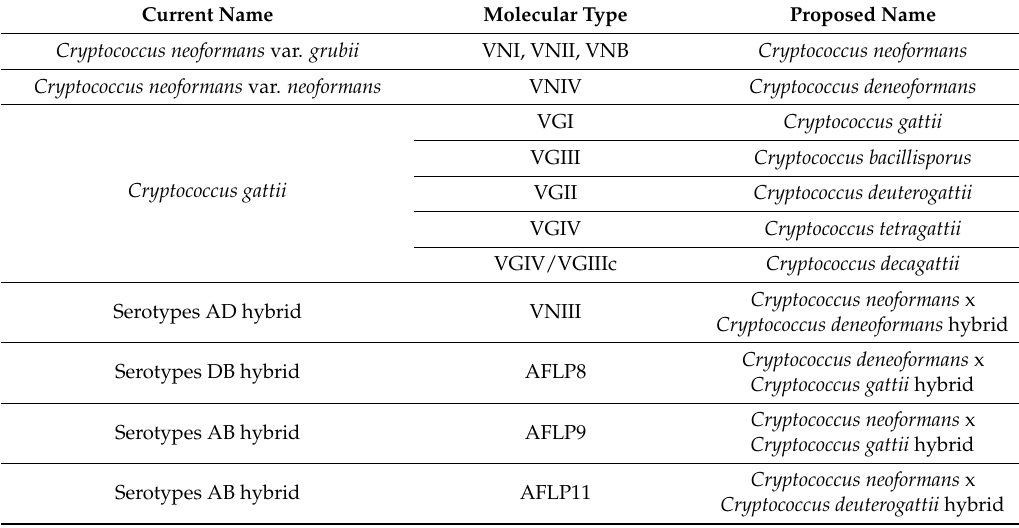
Table 3. Proposed names for Cryptococcus neoformans and C. gattii species